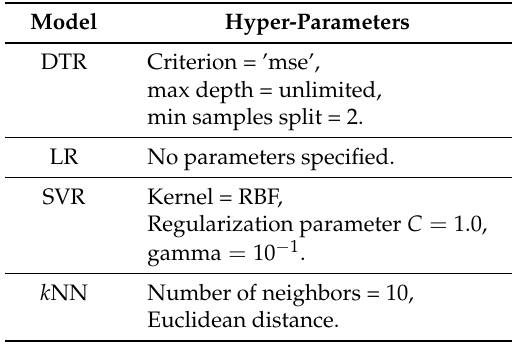
Table 2. Parameter specification of state-of-art algorithms used as